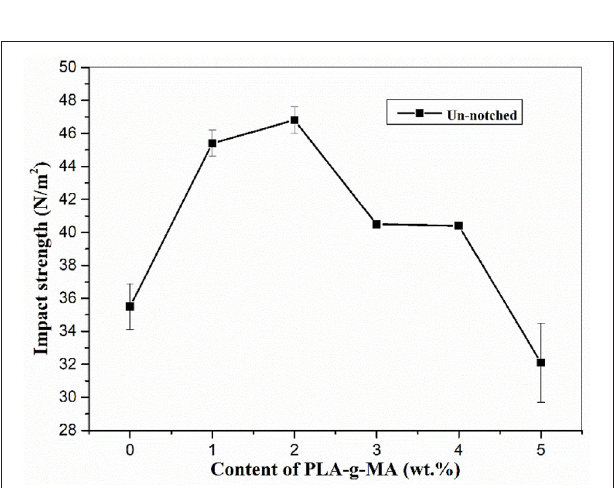
FIGURE 1 | Stress-strain curves of PLA/PA12 blends with varying concentrations of compatibilizer (PLA-g-MA).